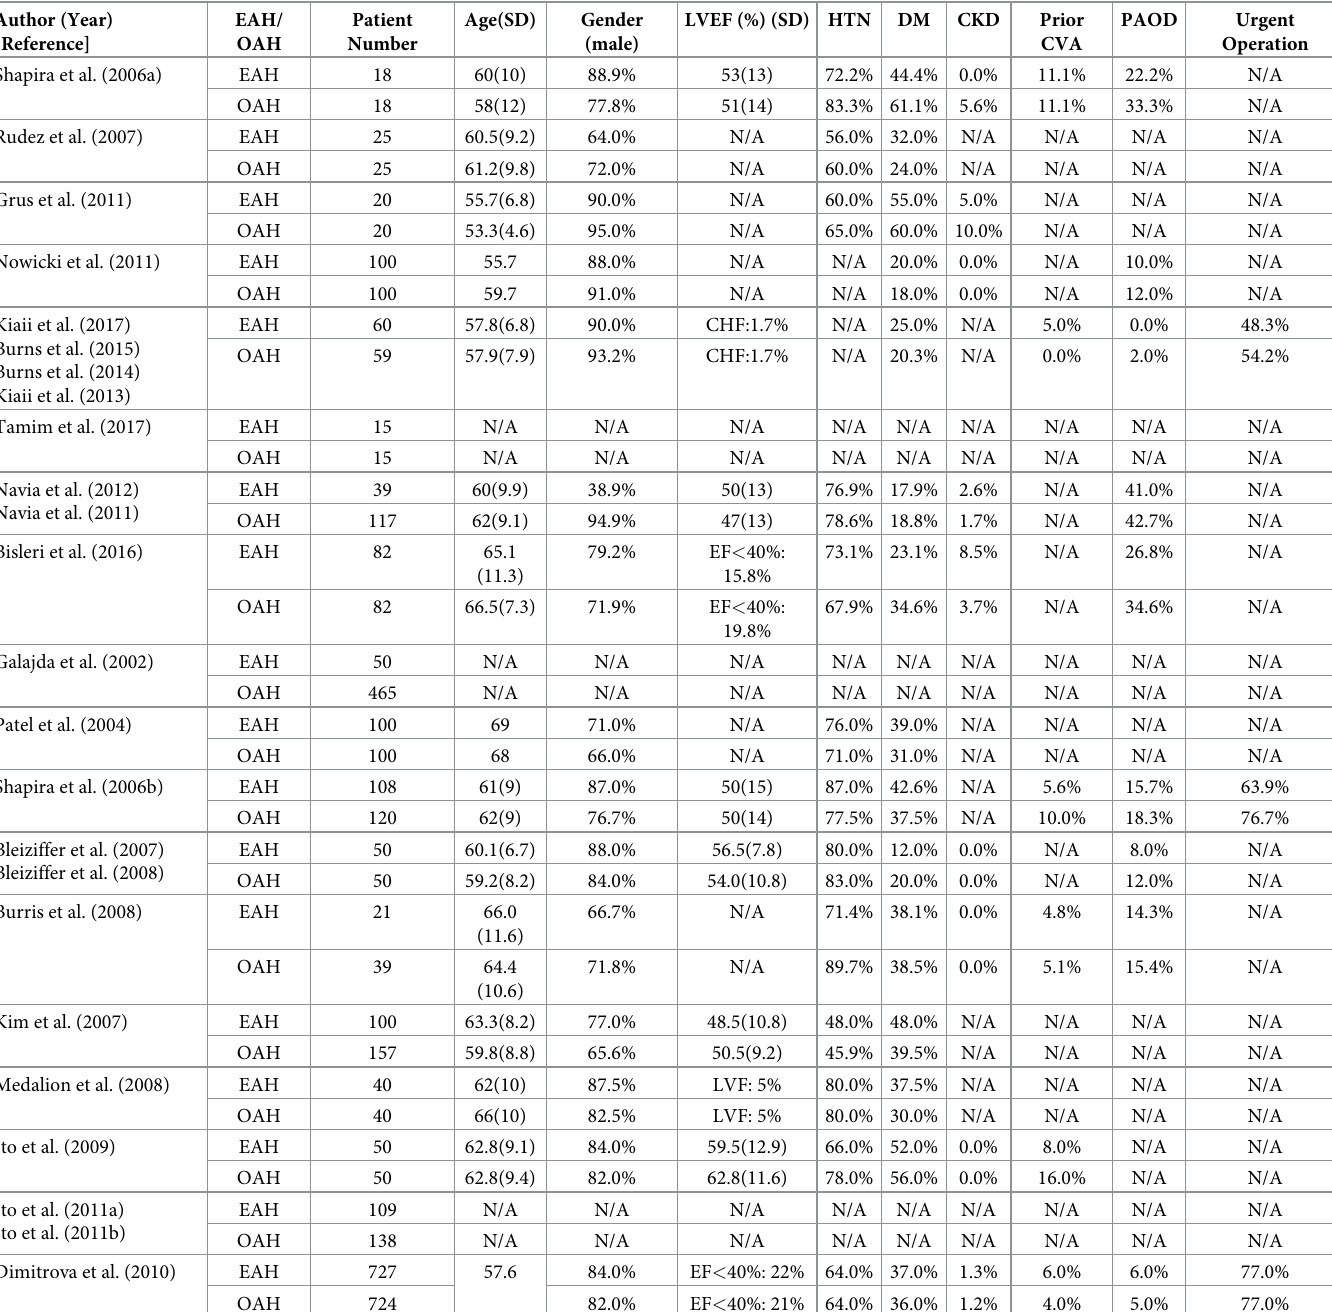
Table 2. The key characteristics of the included